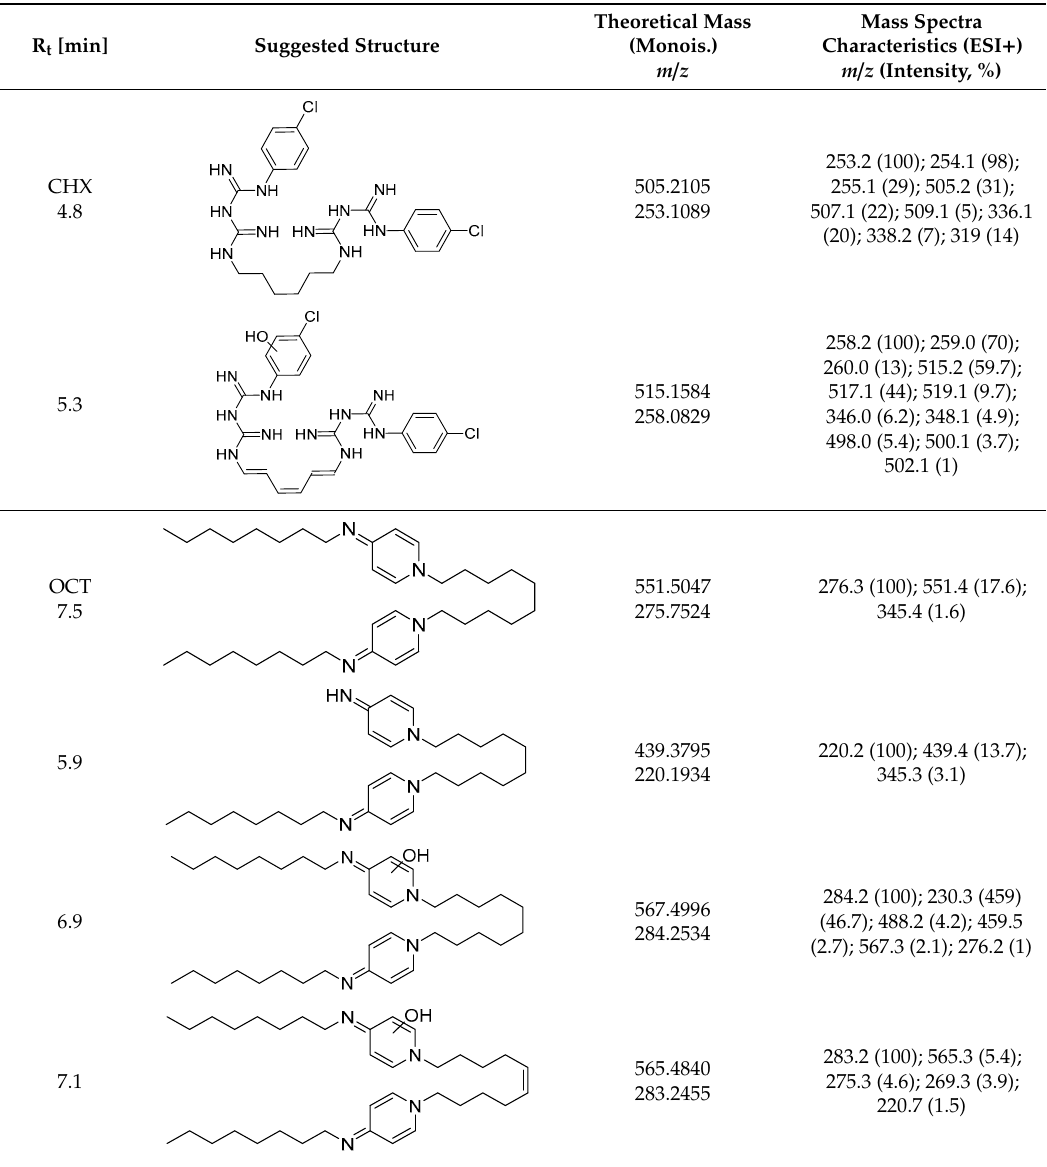
Table 1. Characterization of the detected chlorhexidine (CHX) and octenidine (OCT) metabolites by nontargeted LC-MS.